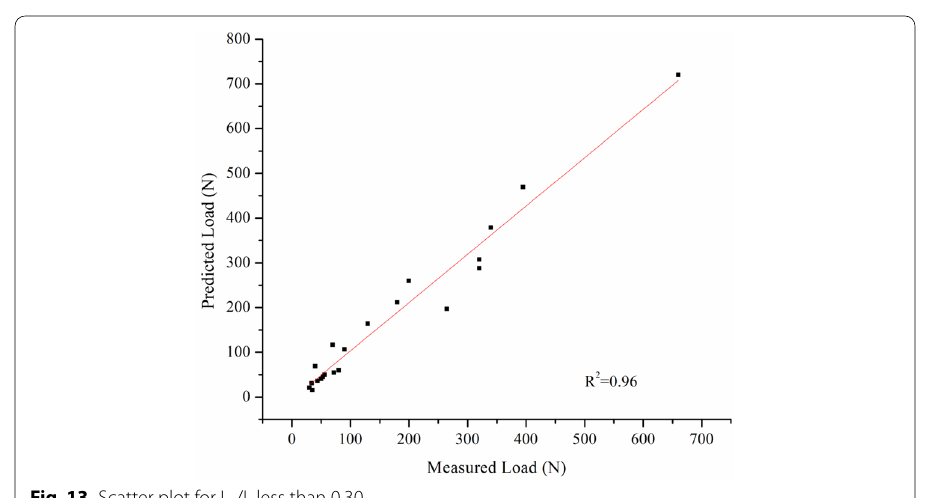
Fig. 13 Scatter plot for L e /L less than